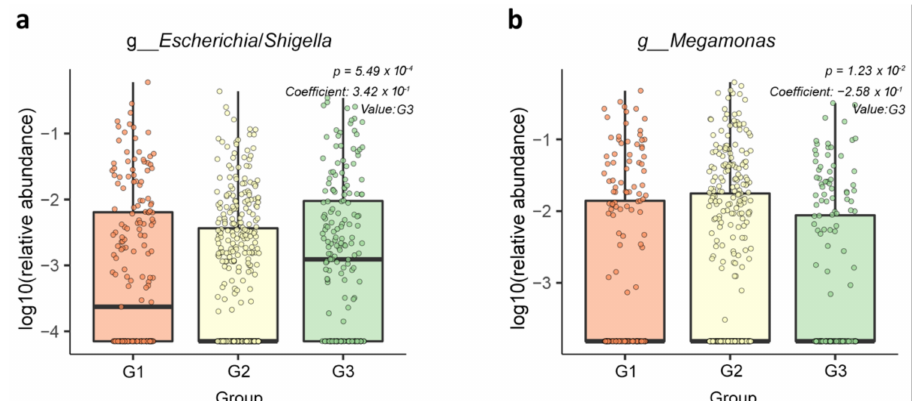
Figure 4. Relative abundance of genera associated with PSA. ( a ) The genus Escherichia/Shigella was more abundant in the G3 group than in the G2 group. ( b ) The genus Megamonas showed lower abundance in the G3 group than in the G2 group. Plots were depicted using MaAsLin2. MaAsLin analyses were performed using default options with adjusting for age and BMI.